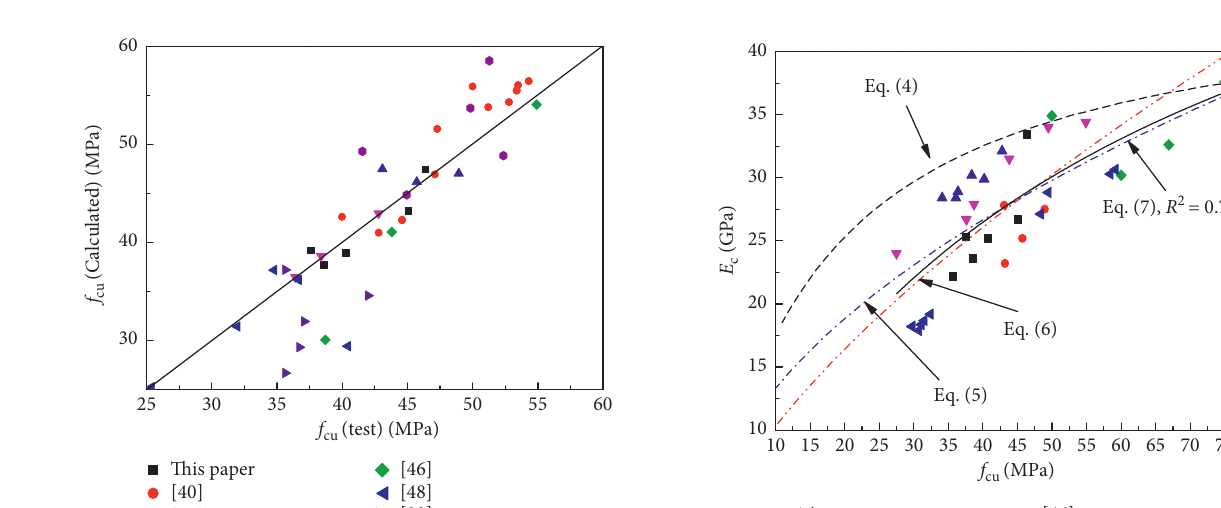
Figure 10: Relationship of f